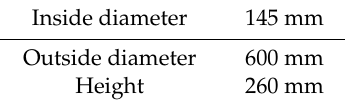
Table 1. 6 polarity electromagnetic system.